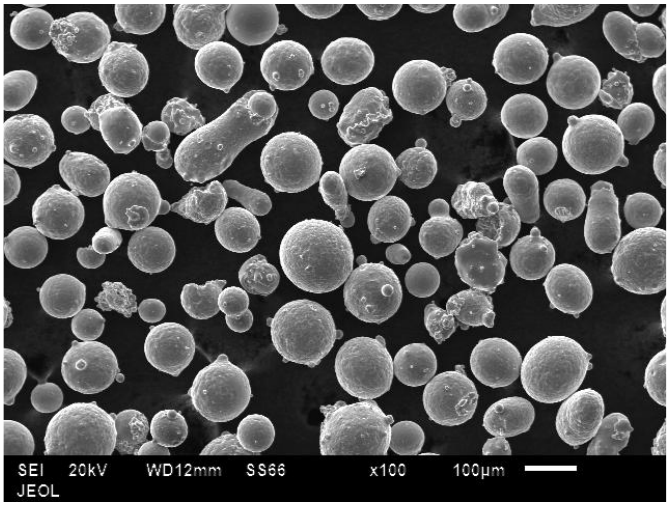
Figure 2. Morphology of γ -TiAl powder particles observed by scanning electron microscope.